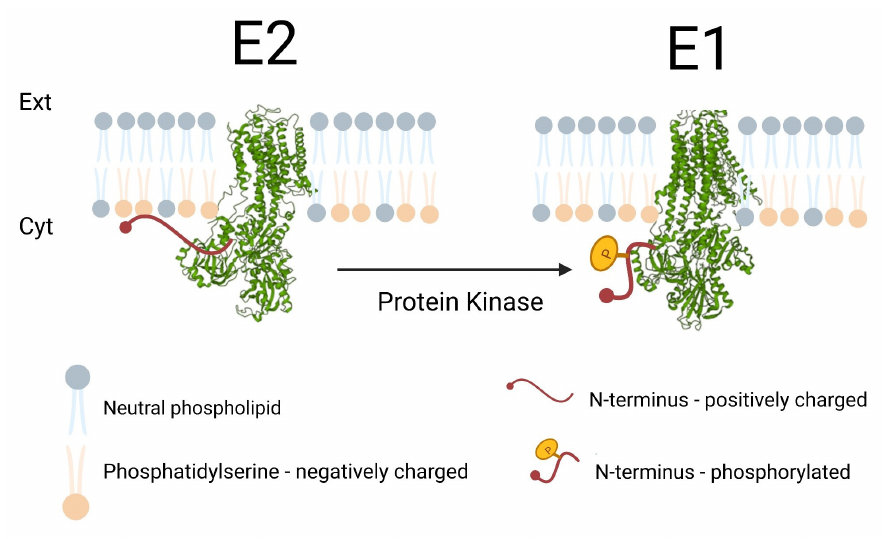
Figure 1. Proposed operation of the electrostatic switch mechanism in the regulation of the Na + , K + -ATPase. The E2 conformation of the enzyme is stabilised through an electrostatic interaction between positively charged lysine residues on the N-terminus and the negatively charged headgroups of phosphatidylserine on the cytoplasmic surface of the surrounding membrane. Phosphorylation of hydroxyl groups of conserved serine and tyrosine residues of the N-terminus by protein kinases introduces negative charges onto the N-terminus, weakening its electrostatic interaction with the membrane and causing its release from the membrane. This destabilises the E2 conformation of the protein and facilitates its conformational change into the E1 state. The E2 and E1 structures shown in the figure were derived from published crystal structures PDB 3B8E in the case of the E2 state [7] and PDB 3WGU in the case of the E1 state [8].